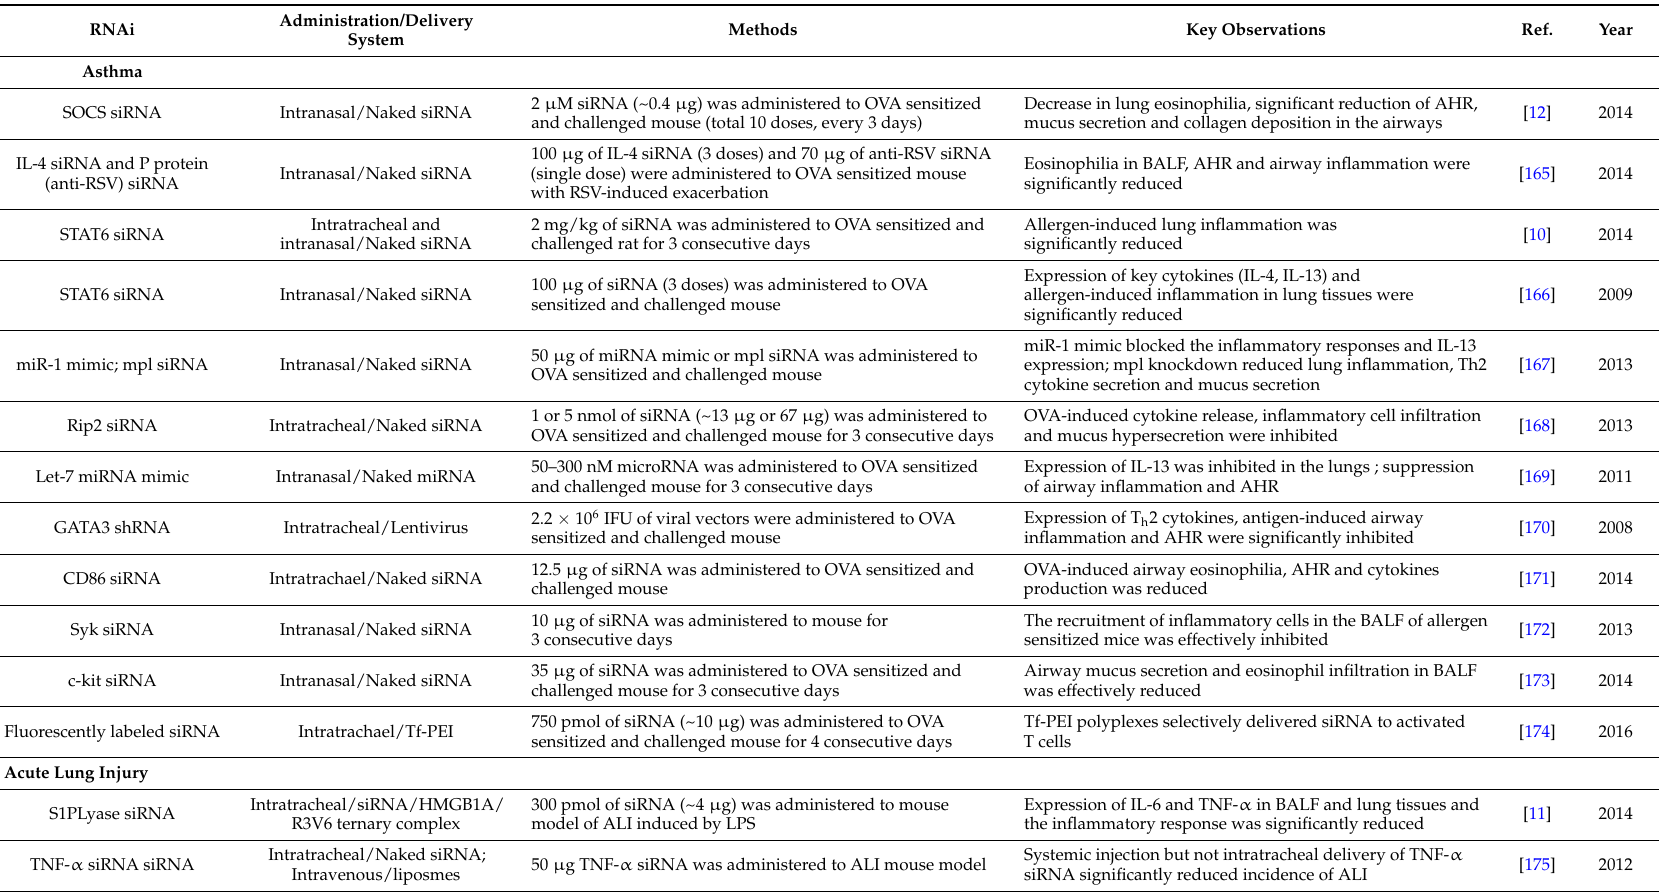
Table 4. Selected in vivo studies of using RNAi therapy on respiratory inflammatory